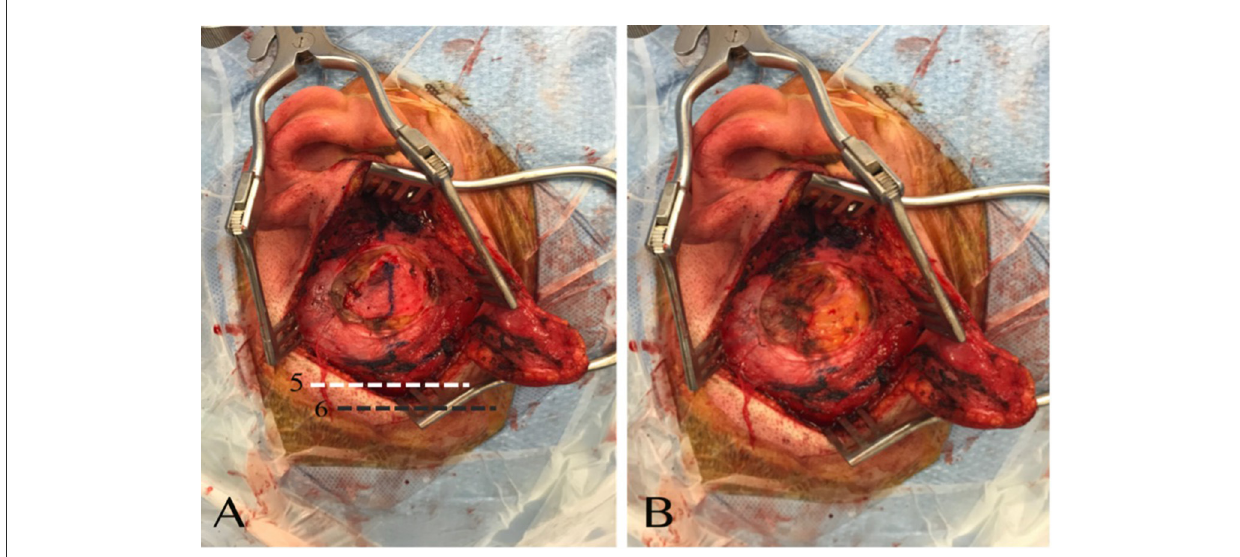
FIGURE4 (A) The plan over the temporalis fascia is dissected, and the fascia exposed. (B) Temporalis fascia is harvested. (5) Demonstration of the level of the temporalis muscle flap incision. (6) Demonstration of the level of the skin incision with respect to the temporalis muscle flap incision.